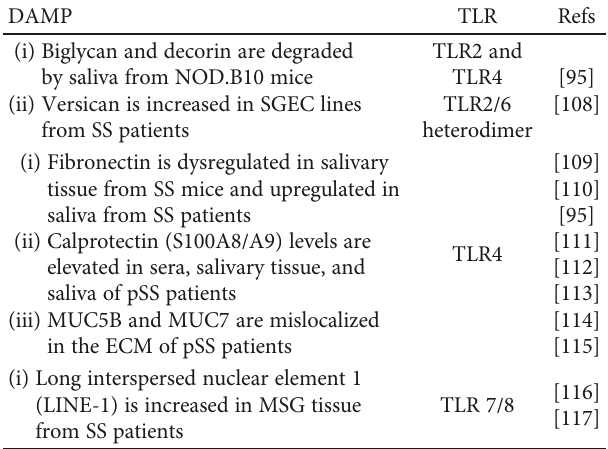
Table 4: Summary of putative DAMP/TLR interactions in SS. DAMP TLR Refs by saliva from NOD.B10